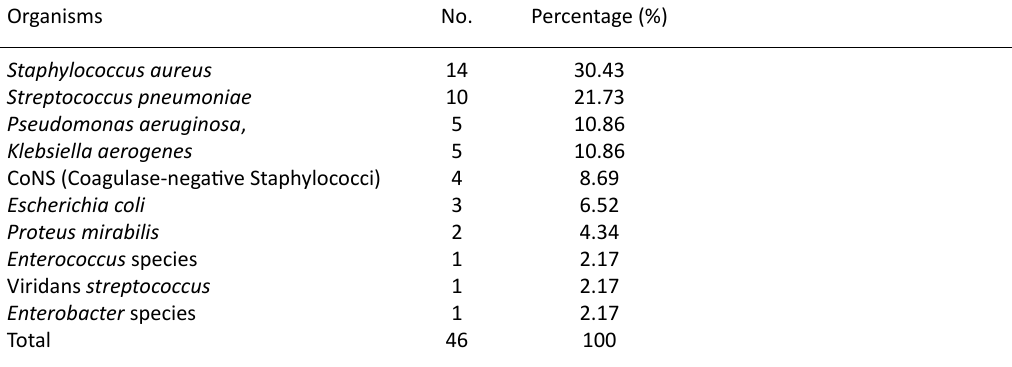
Table 4. Spectrum of clinical isolates causing chronic dacryocystitis (n=46) Organisms No. Percentage (%) Staphylococcus aureus Pseudomonas aeruginosa , Klebsiella aerogenes